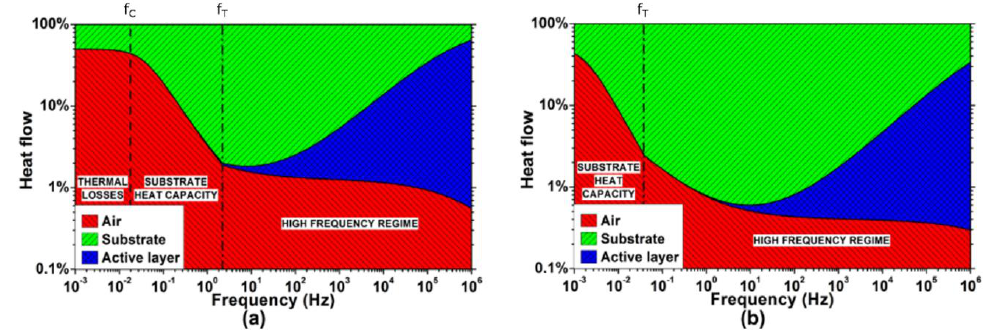
Figure 6. Simulated distribution of the heat flows in the TA loudspeaker: ( a ) Kapton substrate; ( b ) glass substrate. Logarithmic scale has been used to better visualize the fraction of heat flow injected into the air.